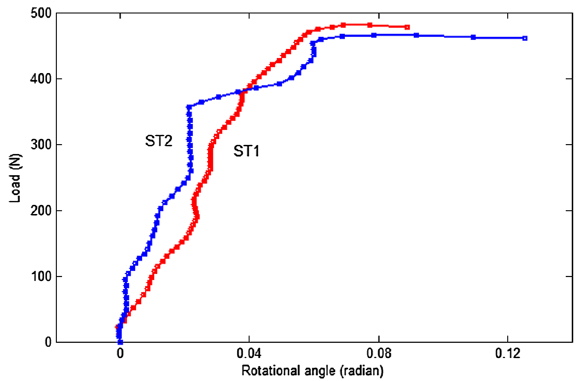
Fig. 11 Rotational angle of the beam at the mid-span.